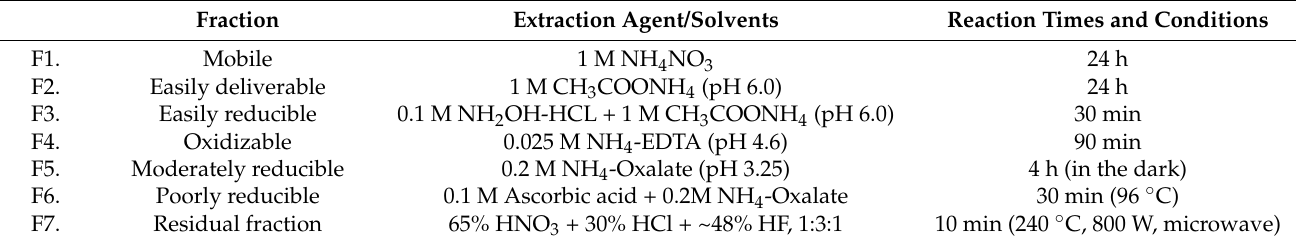
Table 3. The sequential extraction